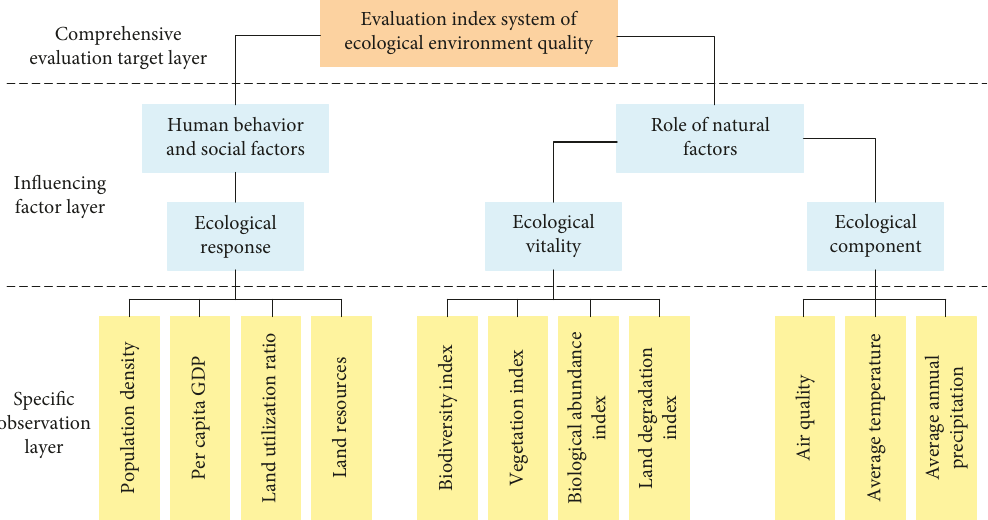
Figure 9: Hierarchical structure diagram of comprehensive average index system of ecological environment Table 1: Evaluation index weight factor judgment table. Evaluation index